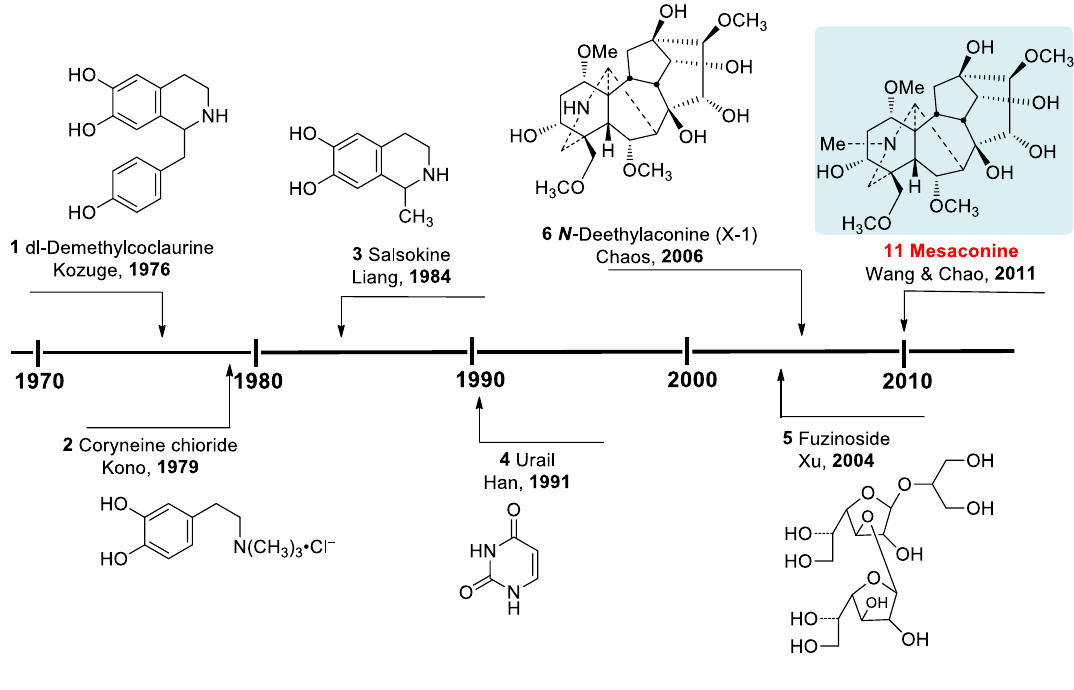
Fig. 2 Known cardioactive ingredients of “Fu